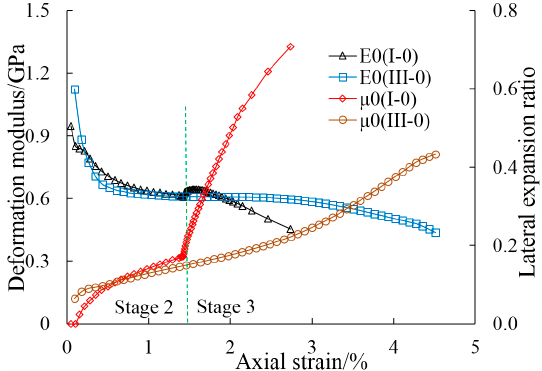
Figure 7. Change of the deformation modulus and lateral expansion ratio of coal I-0 and III-0 (Stage 2 and Stage 3 in reference to Stress Path